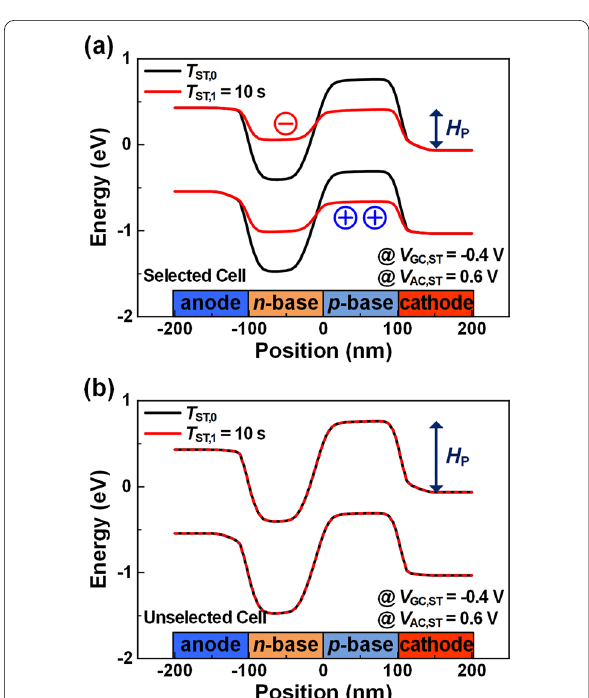
Fig. 6 Energy band diagrams of a the selected cell for programming at T ST,0 (black line) and T ST,1 unselected cells at T ST,0 (black line) and T ST,1